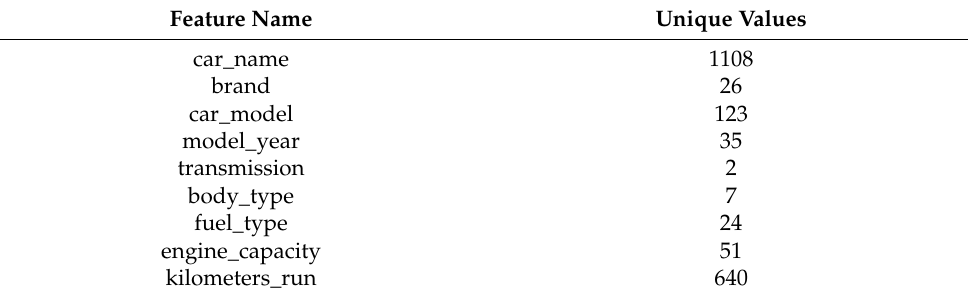
Table 2. Number of unique values for all the